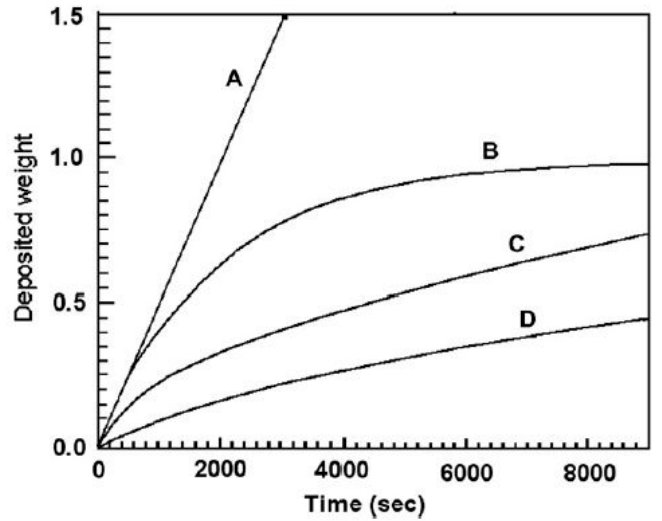
Figure 4. Deposition time vs. deposition weight graph under different processing conditions. Reproduced from [68] with permission from Wiley™.